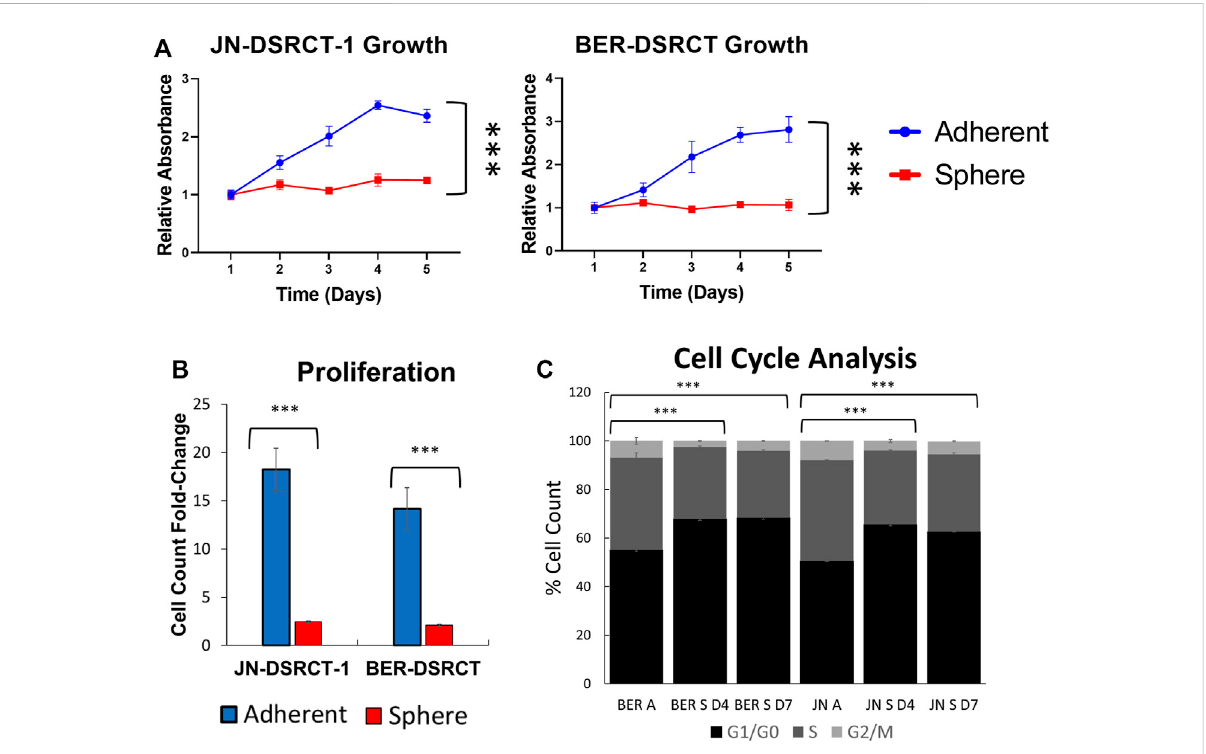
FIGURE 4 DSRCT CSC-like cells are quiescent. (A) Growth of JN-DSRCT-1 and BER-DSRCT cells in adherent or sphere culture conditions for 5 days as determinedbyCCK-8(*** p -value < 0.001,ANOVA). (B) ProliferationofJN-DSRCT-1andBER-DSRCTcellsinadherentorspherecultureconditions for 5 days assessed as fold-change in cell count. (C) Cell cycle analysis of JN-DSRCT-1 and BER-DSRCT cells grown in adherent culture, 4 or 7 days of sphere